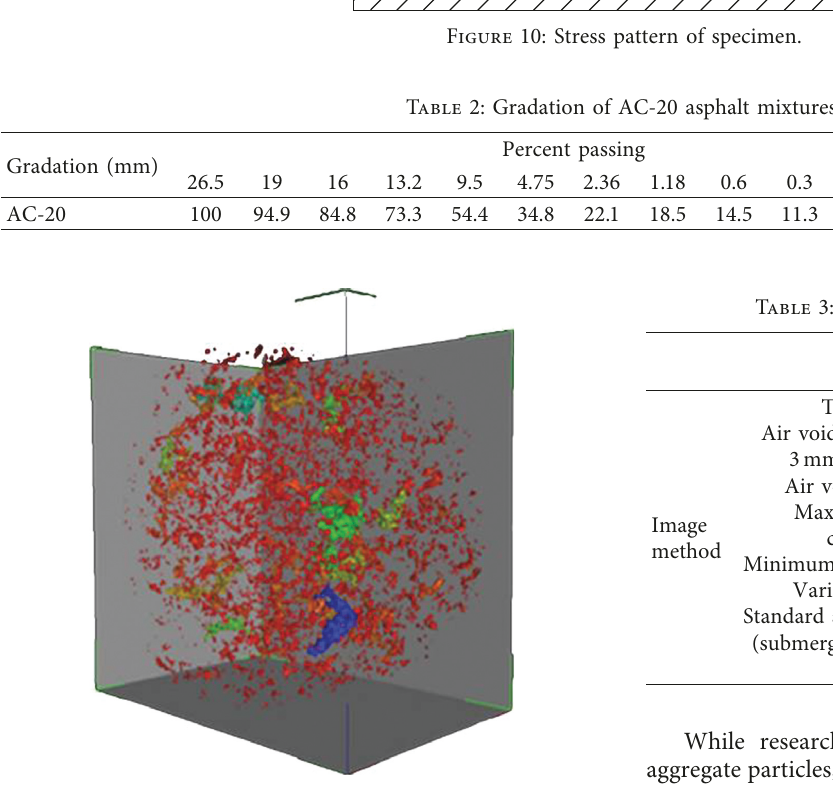
Figure 11: 3D image of air voids.